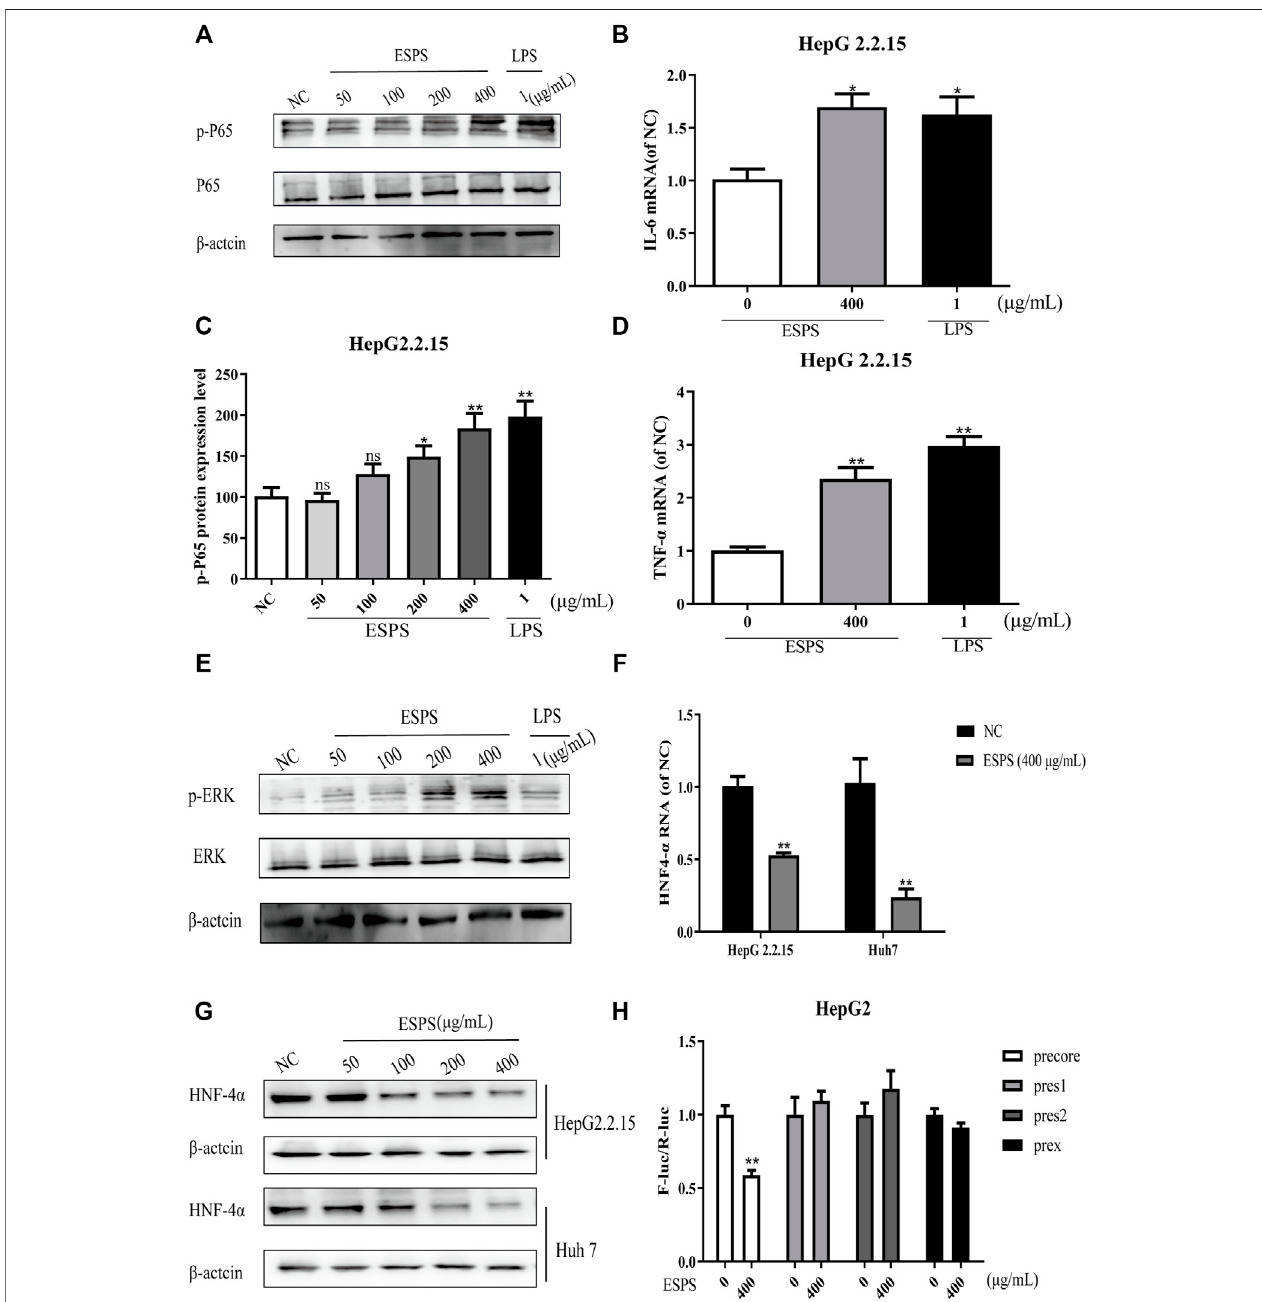
FIGURE4| EffectsofESPSonNF- κ BandERKsignalingpathways invitro .HepG2.2.15cellsweretreatedwithindicatedcompoundsfor16 h;thephosphorylation and totalexpression ofNF- κ BproteinswereevaluatedbyWestern blottinganalysis (A) .Quanti fi cation ofimmunoblot fortheratioofp-NF- κ BortotalNF- κ Bprotein to β - actin protein, respectively. The ratio for non – drug-treated control cells was assigned values of 1.0 (C) . The mRNA levels of IL-6 (B) and TNF- α (D) were evaluated by qPCR. The phosphorylation and total expression of ERK1/2 proteins were evaluated by Western blotting analysis (E) . The protein level (F) and mRNA level (G) of HNF4 α were detected by Western blotting and qPCR analysis, respectively. After HBV promoter was transfected, HepG2 cells were treated with ESPS. Then the promoter activity was analyzed by double luciferase (H) . Values are means ± SD ( n = 3). * p < 0.05, ** p < 0.01 vs . control group.